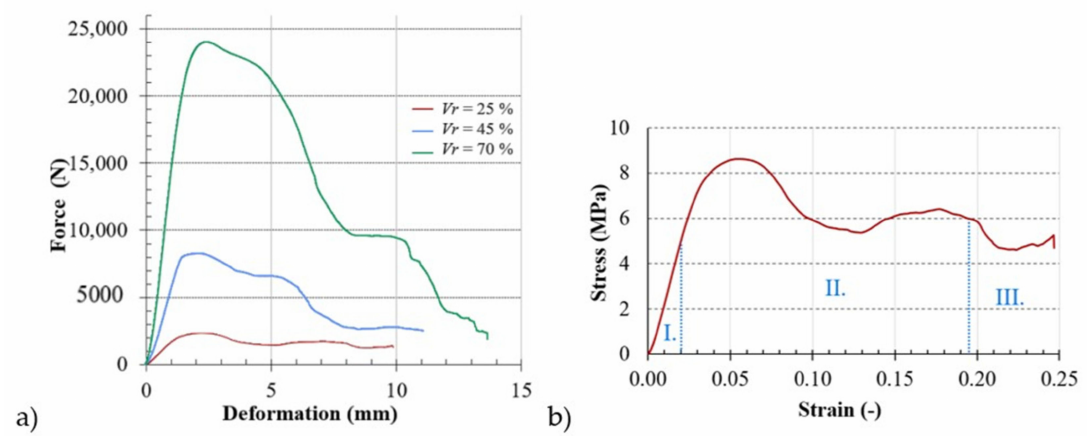
Figure 9. Engineering dependences: ( a ) load vs. displacement of the samples with a = 5 mm and V r = 25%, 45%, and 70%; ( b ) stress vs. strain curve of the sample with a = 5 mm and V r = 25% with regions I. almost linear elastic region, II. constant plateau region, and III. densification area.